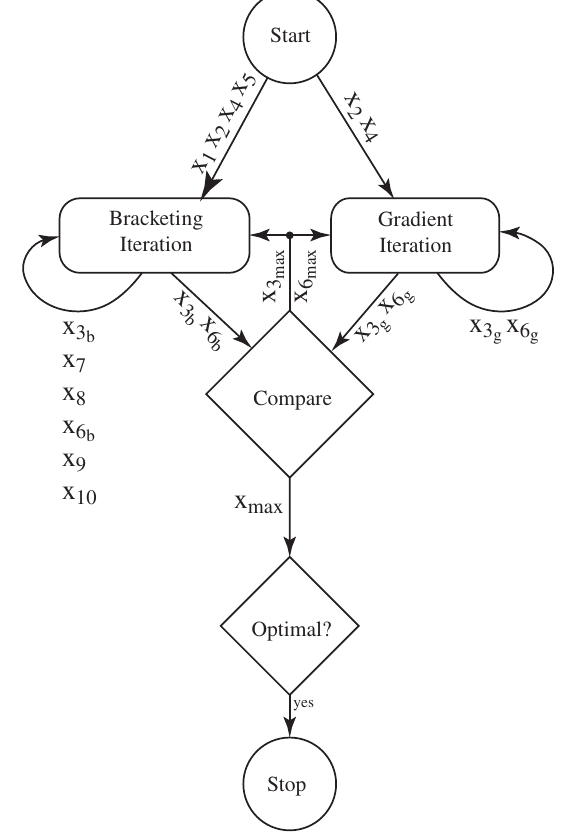
Fig. 13. Multiple bracket cognitive optimization. Increasing the number of messages can address multiple local